Question: In one sentence, what is this figure communicating?
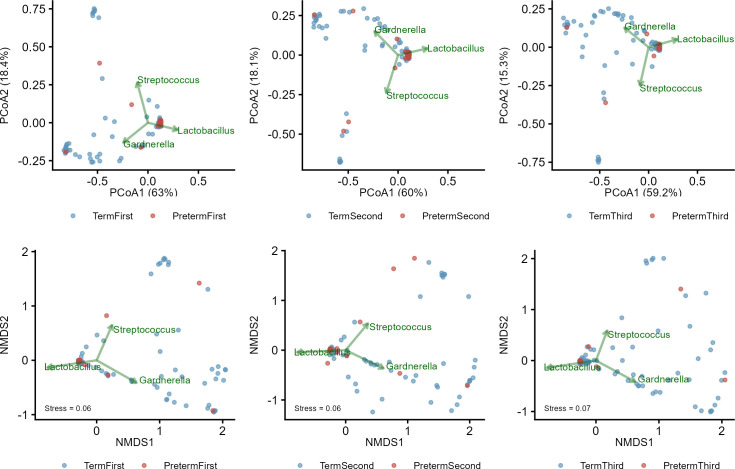
Answer: Beta diversity analysis (Bray-Curtis). PCoA and NMDS plots per trimester showing term (blue) and sPTB (red) samples. Sample sizes: first (term n = 235, sPTB n = 21), second (term n = 246, sPTB n = 24), third (term n = 243, sPTB n = 10). Variance explained in parentheses. ANOSIM R statistics with 95% CI: first ( P = 0.387, q = 0.536), second ( P = 0.117, q = 0.351), third ( P = 0.059, q = 0.315) were not significant. Three clusters driven by (1) Lactobacillus dominance, (2) Gardnerella dominance, (3) Streptococcus /other. Distribution of term/sPTB across clusters did not differ (ANOSIM P > 0.05; Table 2 ).